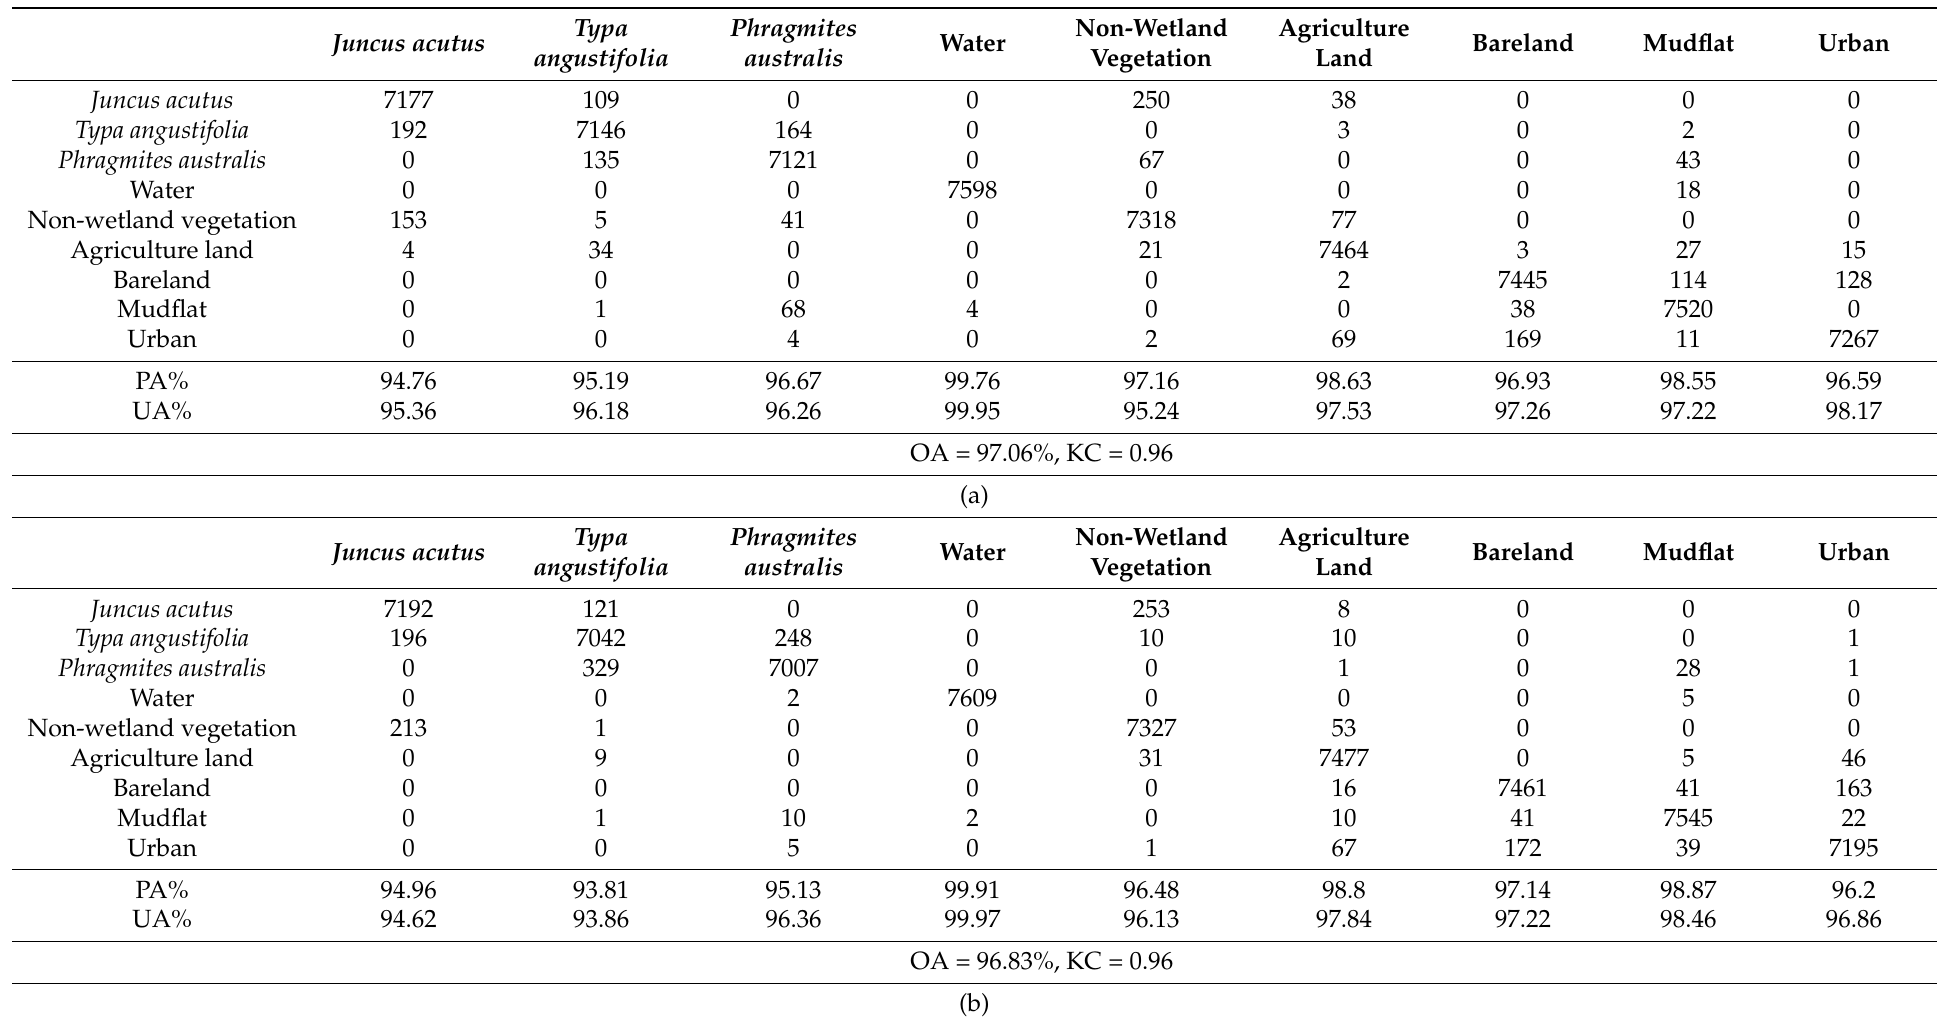
Table 5. The confusion matrices of the target years of (a) 2021, (b) 2019, and (c) 2018 using the samples migrated from reference year